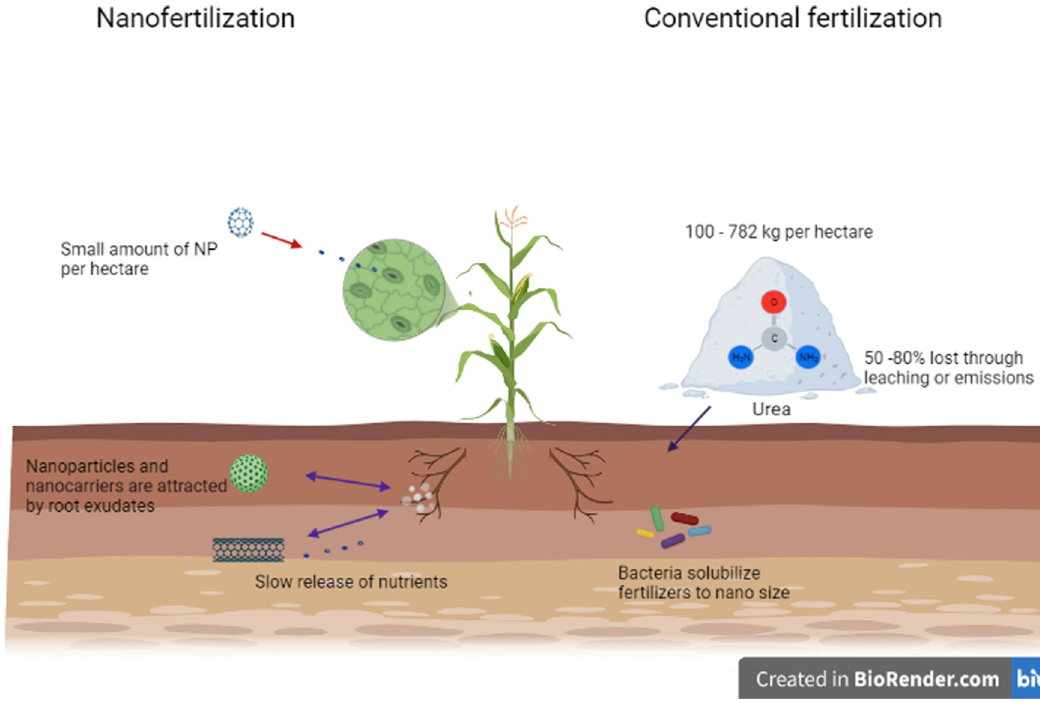
Figure 2: Nanofertilizers versus conventional